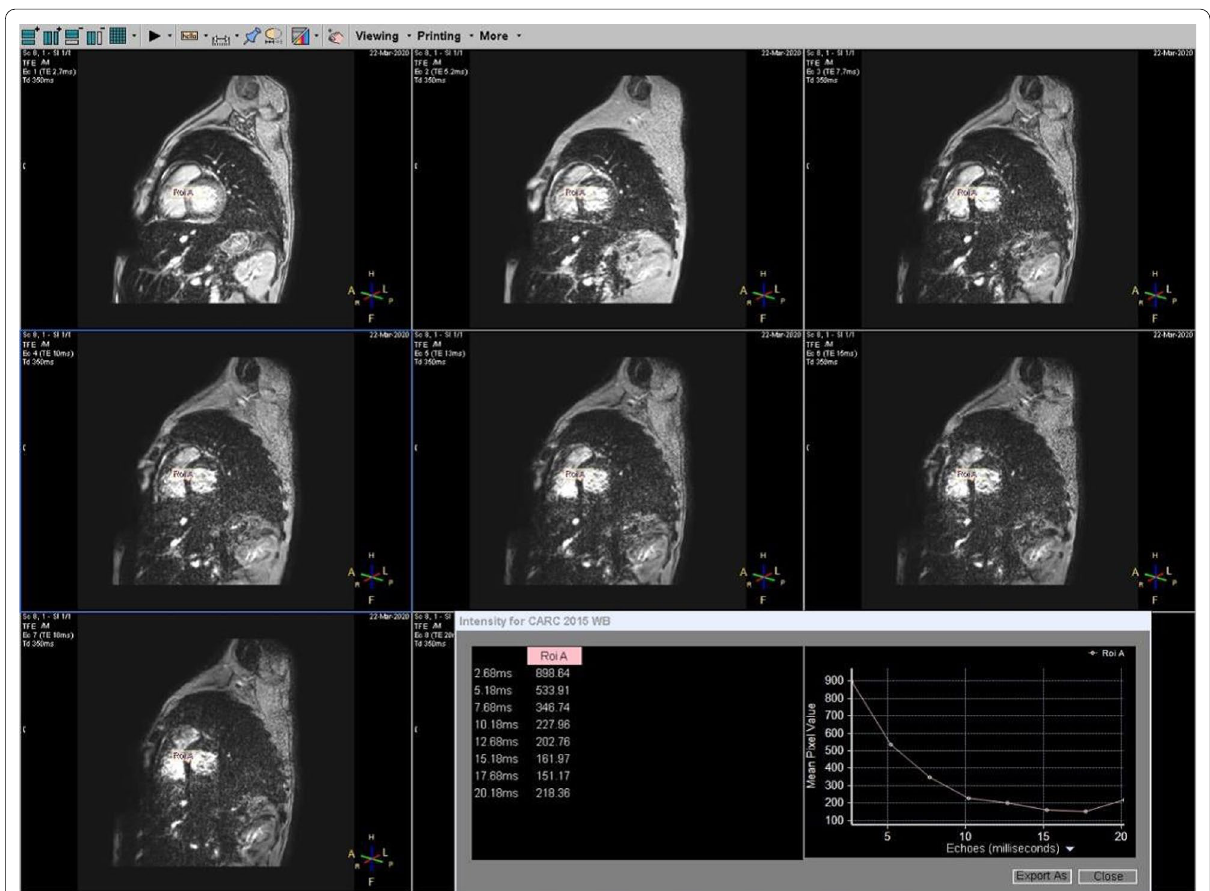
Fig. 3 Left ventricular (LV) short-axis MRI in an 8-year-old male child with TM using gradient-echo sequence with multiple echo times (TEs) for evaluation of T2*. ROI is drawn at mid-IVS. Note that the signal intensity of the interventricular septum becomes dark at greater TEs denoting severe iron